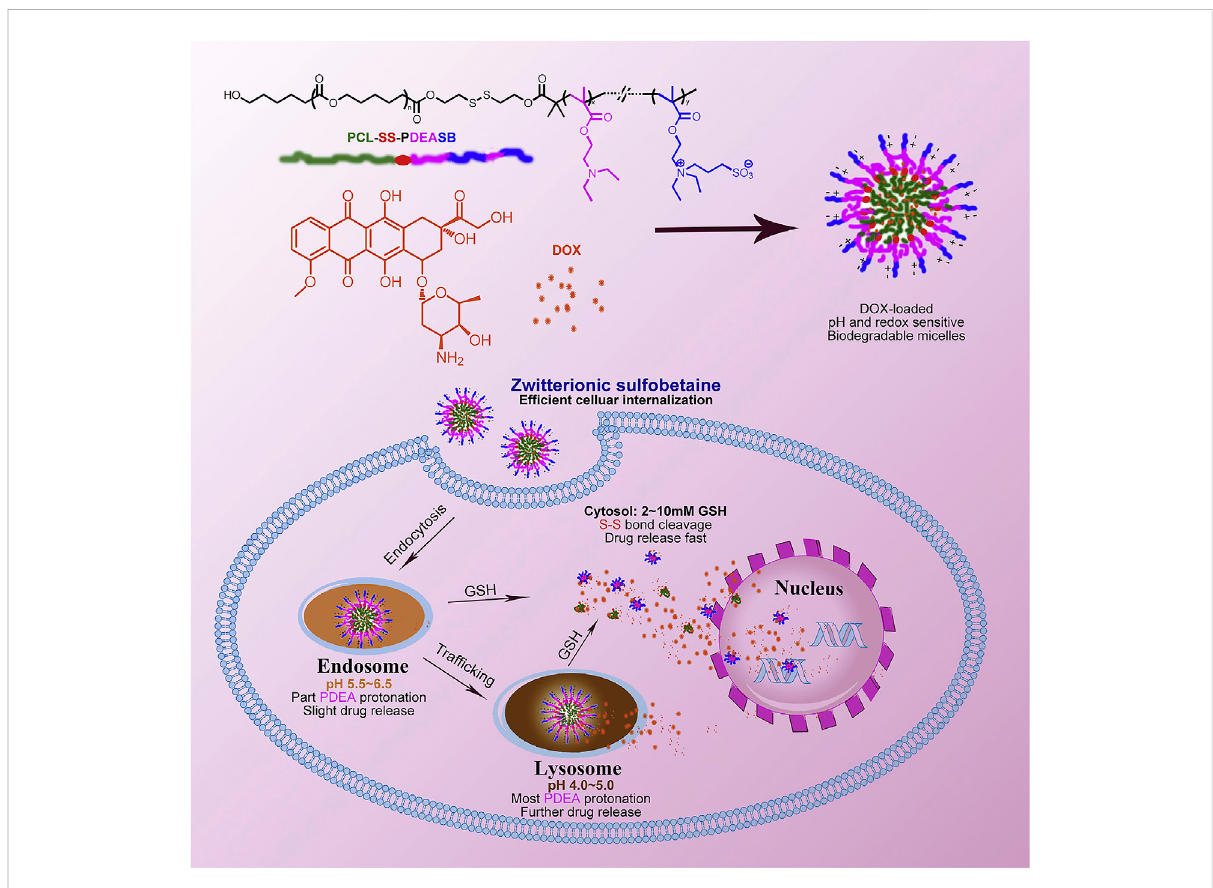
FIGURE 2 pH- and redox-sensitive micelles containing sulfobetaine for intracellular cell drug release. Adapted with permission from Cai et al.